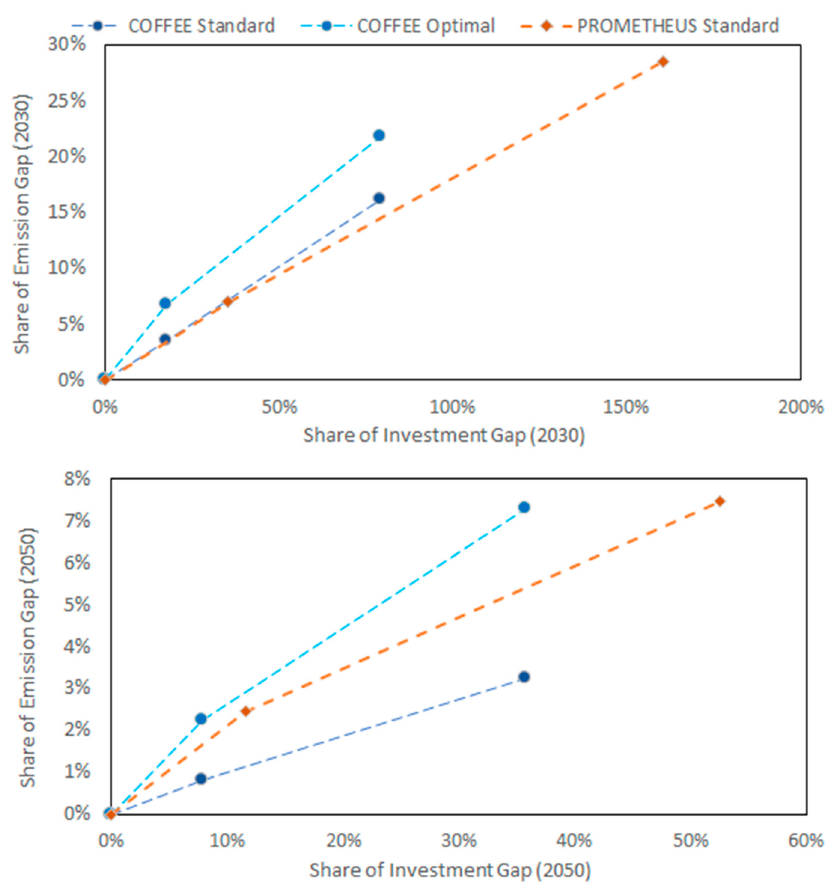
Figure 4. Ambition gap and investment gap in 2030 and 2050.